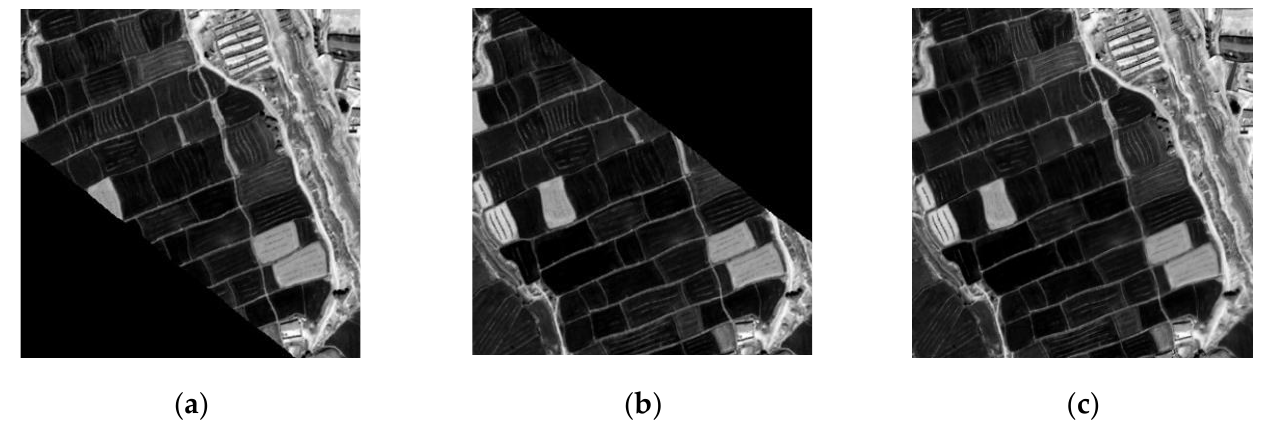
Figure 10. Local magnification experimental results in stable flight: ( a ) left image before merge; ( b ) middle image before merge; ( c ) stitched image.